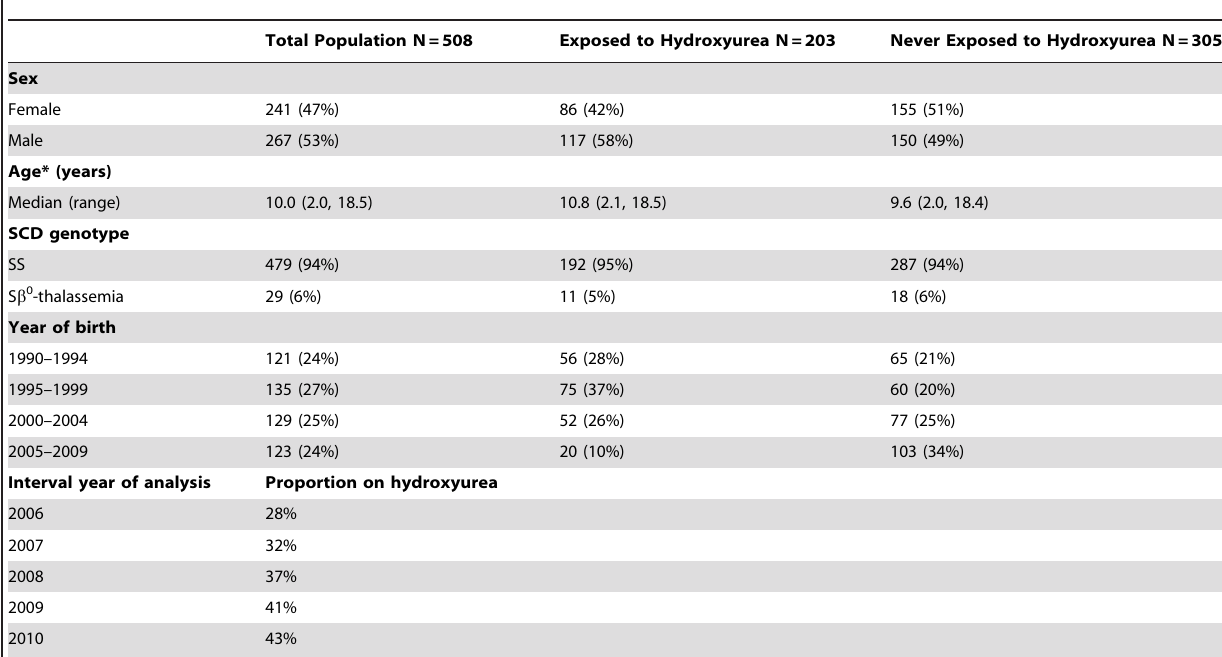
Table 1. Characteristics of the pediatric SCD population eligible for treatment with hydroxyurea from 2006–2010.